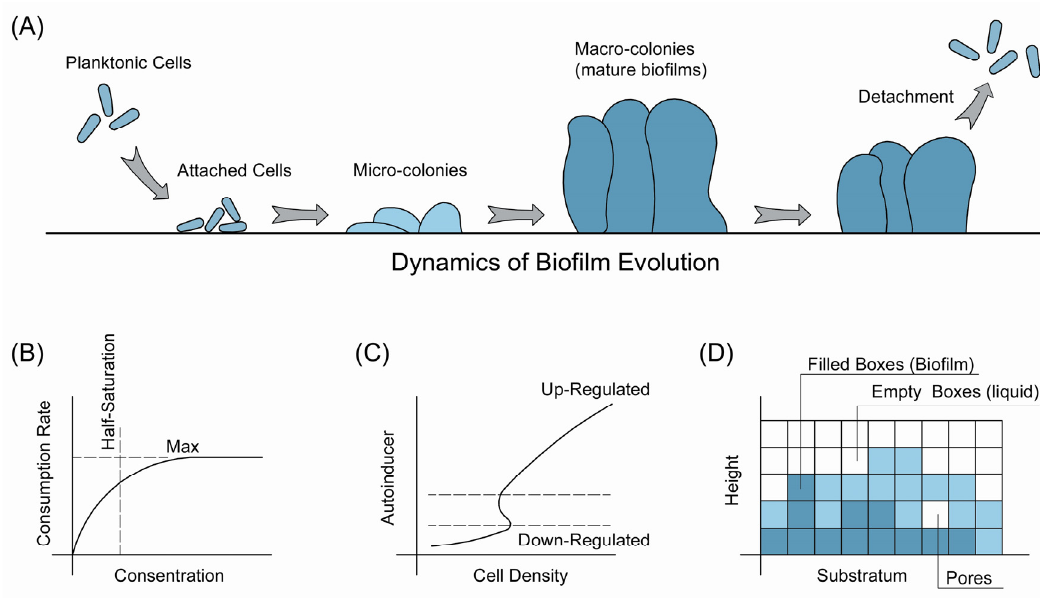
Figure 1. Schemes of biofilm evolution ( A ); the simulation of substrate consumption ( B ); and quorum sensing ( C ) via current 1D model; and the illustration of the multidimensional cellular automata model ( D ).